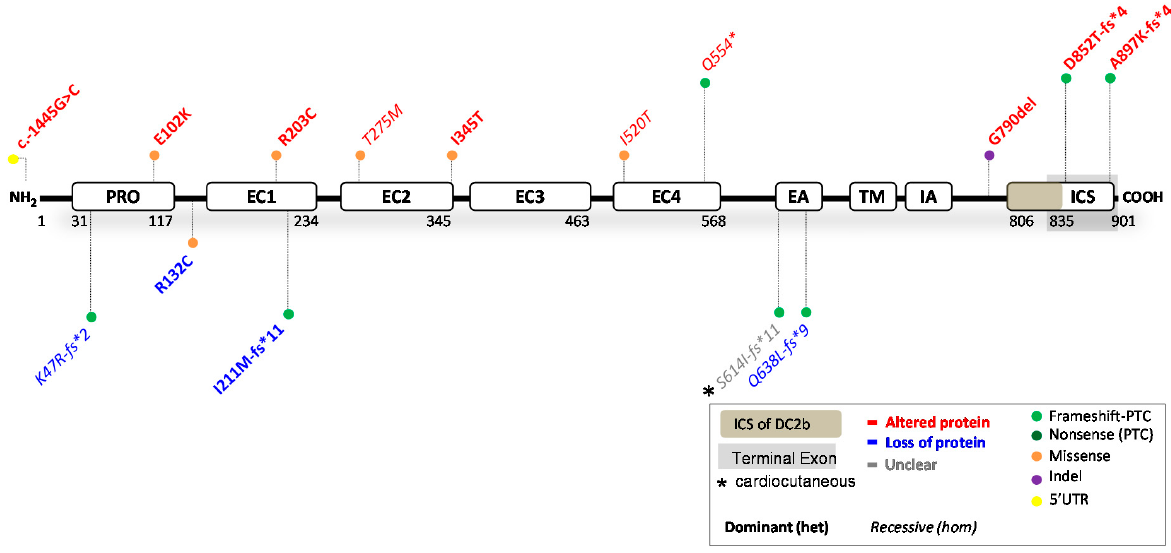
Figure 4. Location of functionally investigated DSC2 variants.